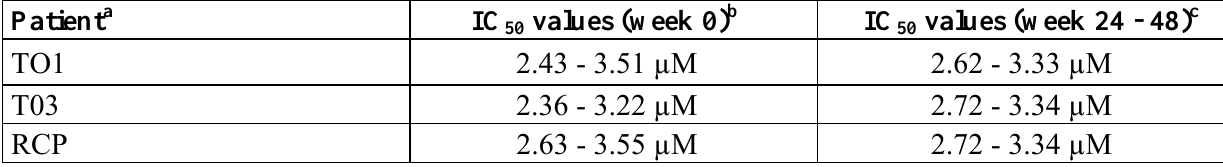
Table 2. Phenotypic susceptibility of the newly synthesized macrocyclic